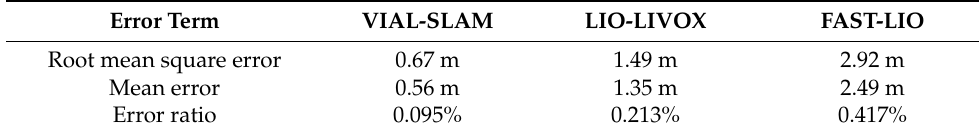
Table 1. The campus environment test results.